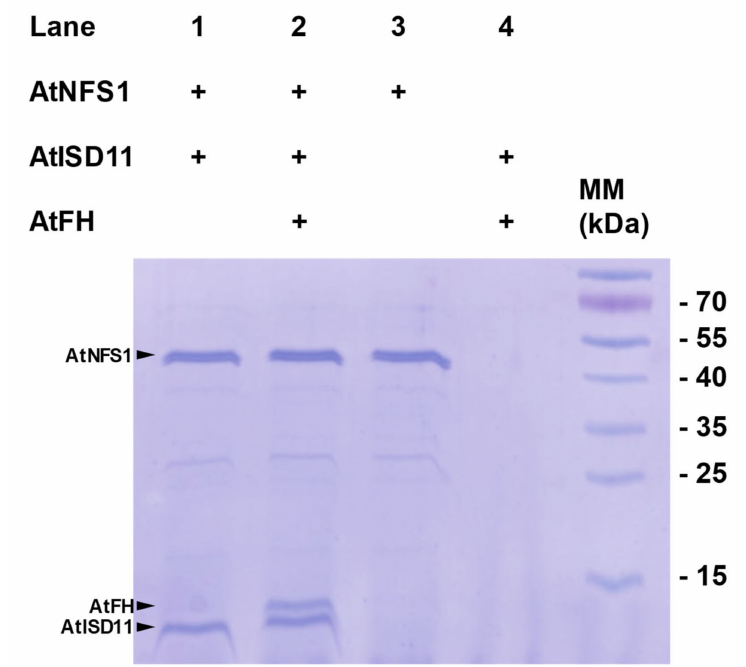
Figure 2. Sodium dodecyl sulfate-polyacrylamide gel electrophoresis (SDS-PAGE) analysis of recombinant proteins. SDS-PAGE analysis of the pull-down assay of the recombinant proteins AtNFS1 (containing a His 6 sequence), AtISD11 and AtFH. Lane 1, AtISD11 was recovered with AtNFS1; lane 2, AtISD11 and AtFH were recovered together with AtNFS1; lane 3, AtNFS1 recovered from the Ni + 2 resin; lane 4, non-specific binding control of AtISD11 and AtFH. MM shows the molecular markers used. Arrows indicate the position of each protein